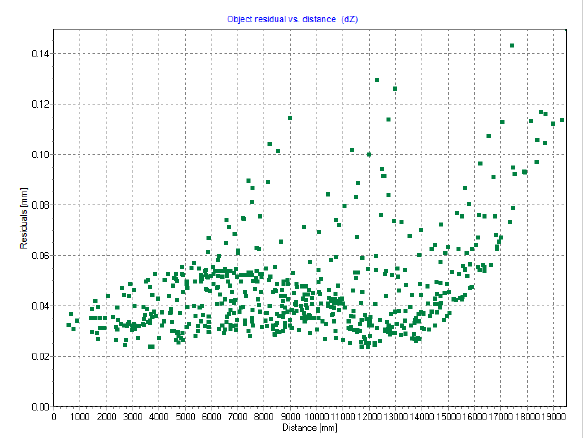
Figure 15: Object residuals as function of point distance Image footprints, distribution of image and object points, histogram and distribution of image and object residuals, length measurement errors and more can be visualized in diagrams (example in Figure 15) and exported to